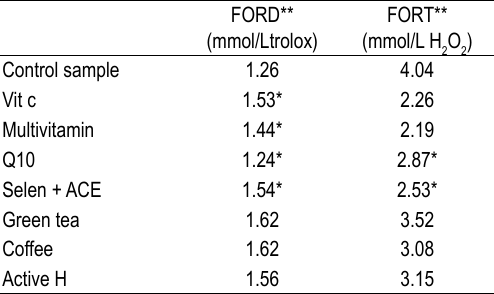
*result after diluting the original sample 10 times ** standard deviation of parallel samples was less than